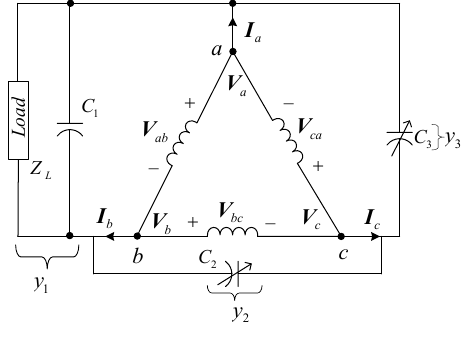
Figure 1. Three-capacitor scheme of SEIG feeding a single-phase